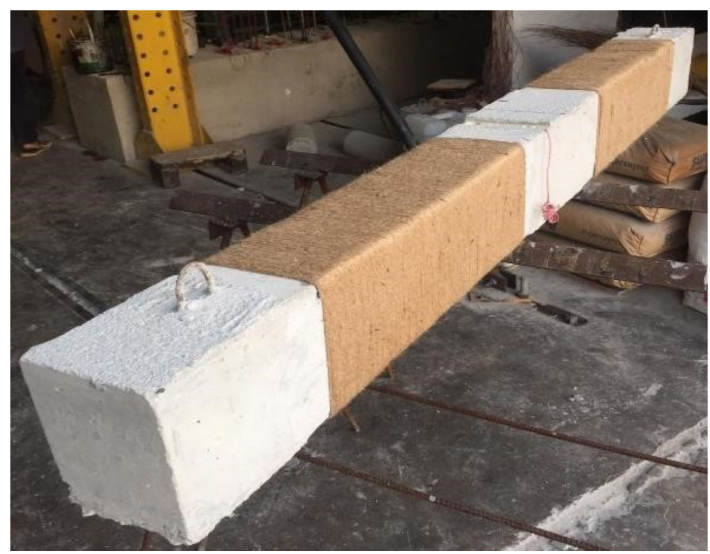
Figure 8. RC beam with strengthening configuration type C natural hemp ropes.